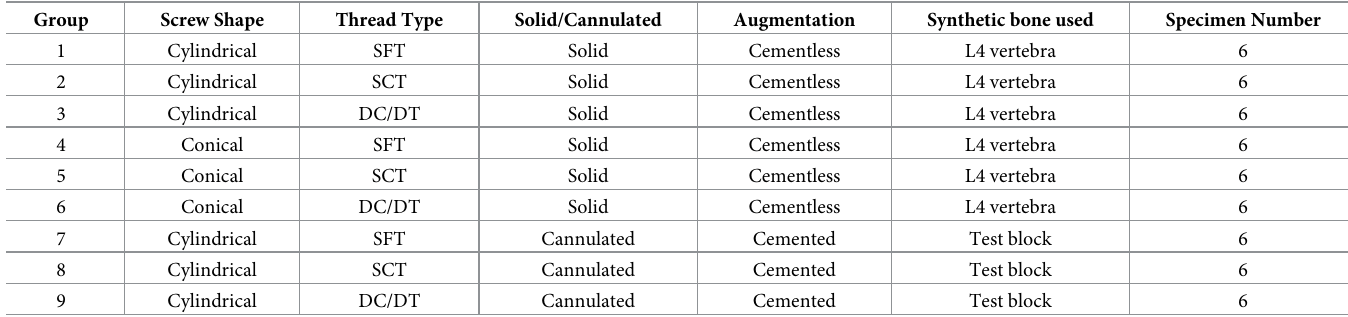
Table 1. Allocation of the specimens to experimental